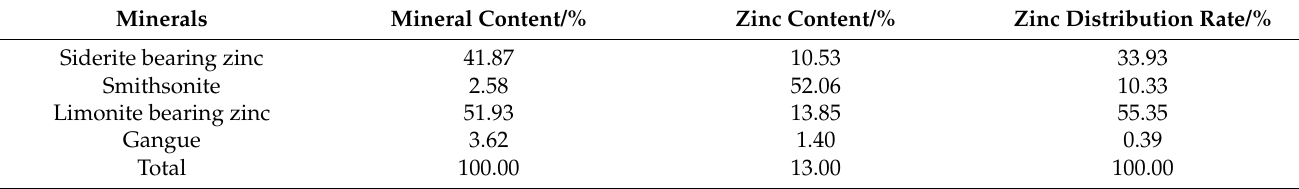
Figure 1. XRD pattern of the raw ore. Table 2. Distribution of zinc in the main minerals of the raw ore sample.